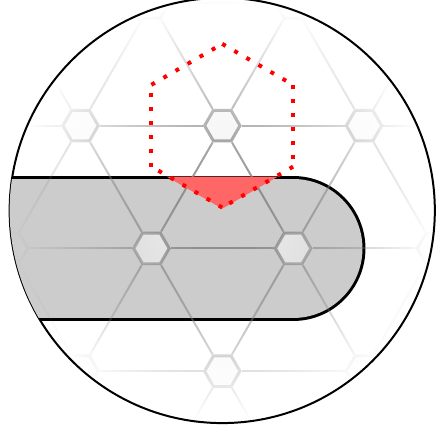
Fig. 6. Total hyphal surface length consists of the cylinder (associ- ated with edges) surface length ( 2 | H i | ∆ x / 2 = 2∆ x ) and the portion of the sphere (associated with a vertex; the dashed circle) not covered by cylinders ( πr / 3 ), less the overlap between cylinders ( 2 r / √ 3